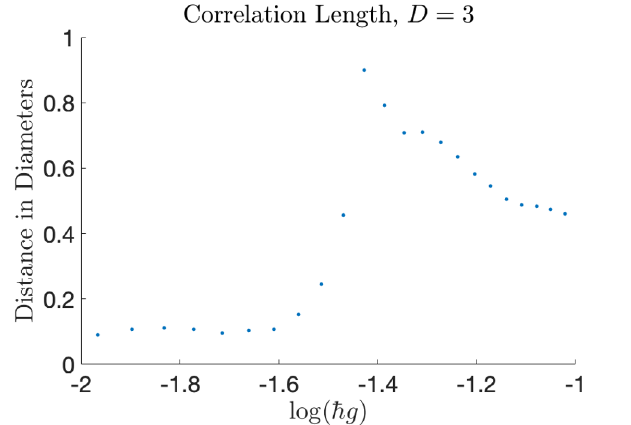
Figure 1 . The square correlation length as a function of the coupling ~ g for